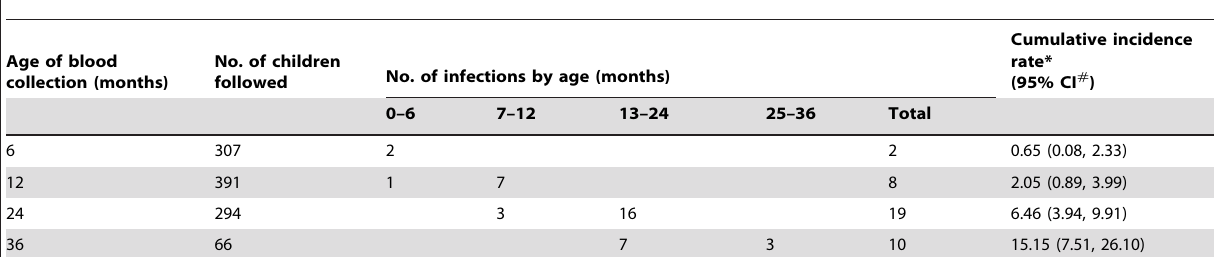
Table 3. Cumulative incidence rates of enterovirus 71 infection in northern Taiwan, 2008–09.